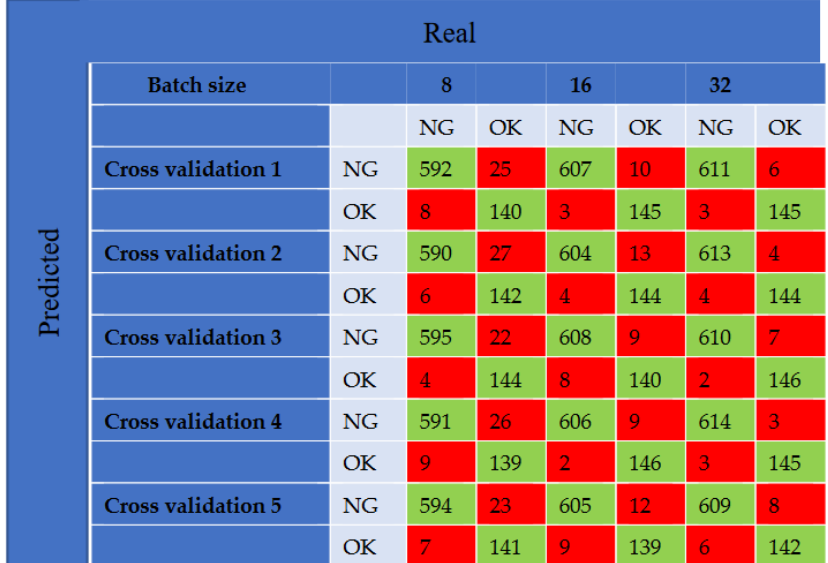
Figure 5. Confusion matrix of five different cross validations for batch size 8, 16 and 32. Note. True positives (TP): PCB predicted as damaged (NG) and is damaged (NG). True negatives (TN): PCB predicted as OK and does not have any damage (OK). False positives (FP): PCB predicted damaged (NG) but does not have any damage. False negatives (FN): PCB predicted as OK but is damaged (NG).